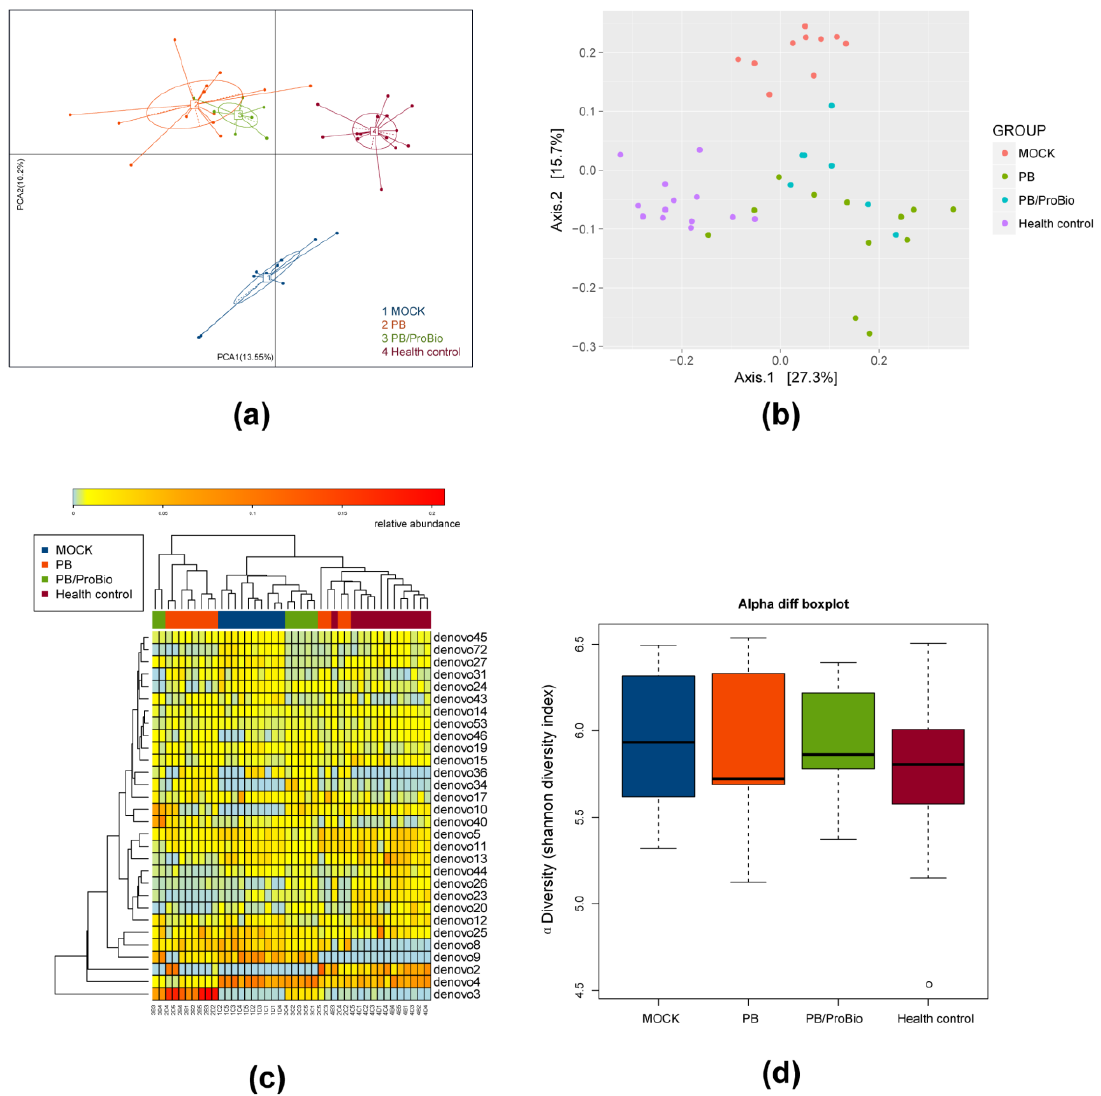
Figure 7. Gut microbiota changes and α- diversity in different groups. ( a ) Principal components analysis (PCA) plot showing microbiota communities cluster with different treatment. ( b ) Non-Metric Multidimensional Scaling (NMDS) plot based on Bray-Curtis distances of the fecal microbiota. Each data point represents a fecal sample from these groups, with the corresponding labels indicated on the right. ( c ) Heatmaps and clustering of individual gut microbiota samples for taxonomic composition. ( d ) Shannon diversity.